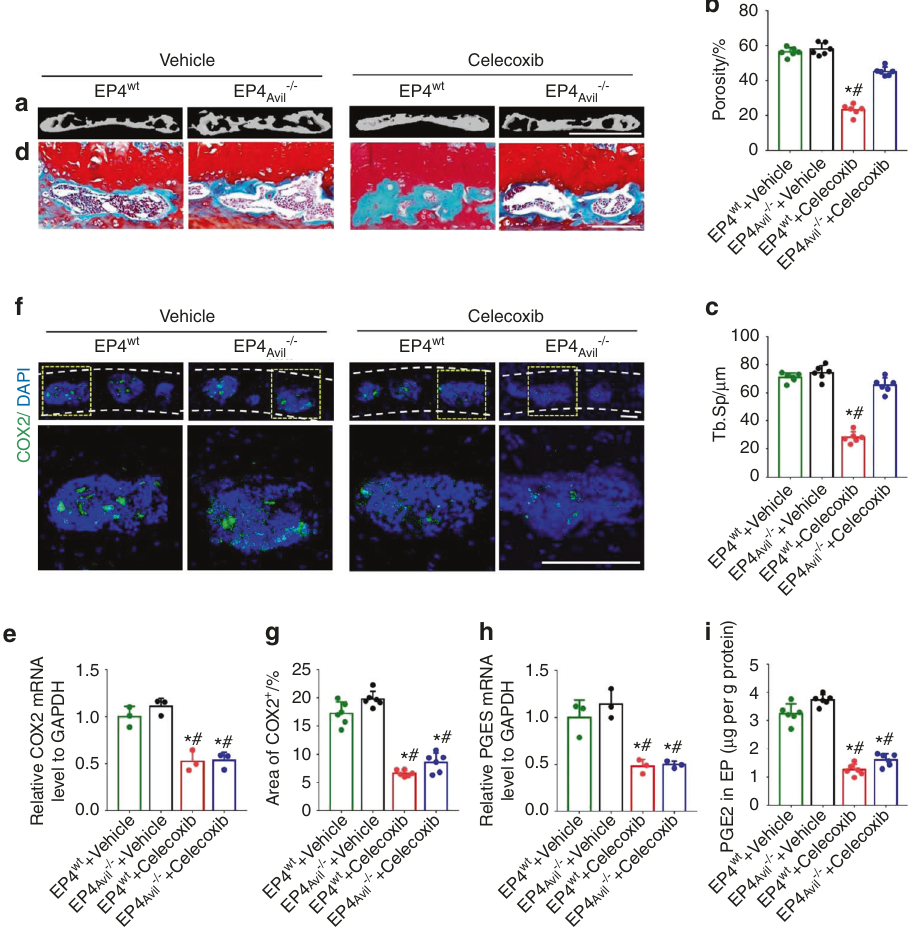
Fig. 5 Knockout of the EP4 receptor in the sensory nerves eliminated the effect of low-dose celecoxib on the reduction of endplate porosity. a Representative μ CT images of the L4-L5 caudal endplates in the EP4 wt or EP4 Avil − / − mice at 4 weeks after celecoxib or vehicle treatment. Scale bars, 1 mm. Quantitative analysis of the total porosity ( b ) and trabecular separation ( c ) of the L4-L5 caudal endplates based on the μ CT images. d Representative images of safranin O and fast green staining of the L4-L5 caudal endplates in the EP4 wt or EP4 Avil − / − mice at 4 weeks after celecoxib or vehicle treatment. e Quantitative analysis of COX-2 mRNA expression in lumbar endplates in the EP4 wt or EP4 Avil − / − mice at 2 weeks after celecoxib or vehicle treatment by qRT-PCR. f Representative images of immunostaining of COX-2 (green) and DAPI (blue) in the L4-L5 caudal endplates in the EP4 wt or EP4 Avil − / − mice at 2 weeks after celecoxib or vehicle treatment. g Quantitative analysis of the percentage of COX-2 + area in lumbar endplates. h Quantitative analysis of PGES mRNA expression in lumbar endplates in the EP4 wt or EP4 Avil − / − mice at 2 weeks after celecoxib or vehicle treatment. i ELISAs of PGE2 concentration in lumbar endplates in the EP4 wt or EP4 Avil − / − mice at 2 weeks after celecoxib or vehicle treatment. Scale bars, 50 μ m ( d, f ). * P < 0.05 compared with the sham group and # P < 0.05 compared with the vehicle group at the corresponding time points. n = 3 per group ( e , h ); n = 6 per group ( b, c, g, i